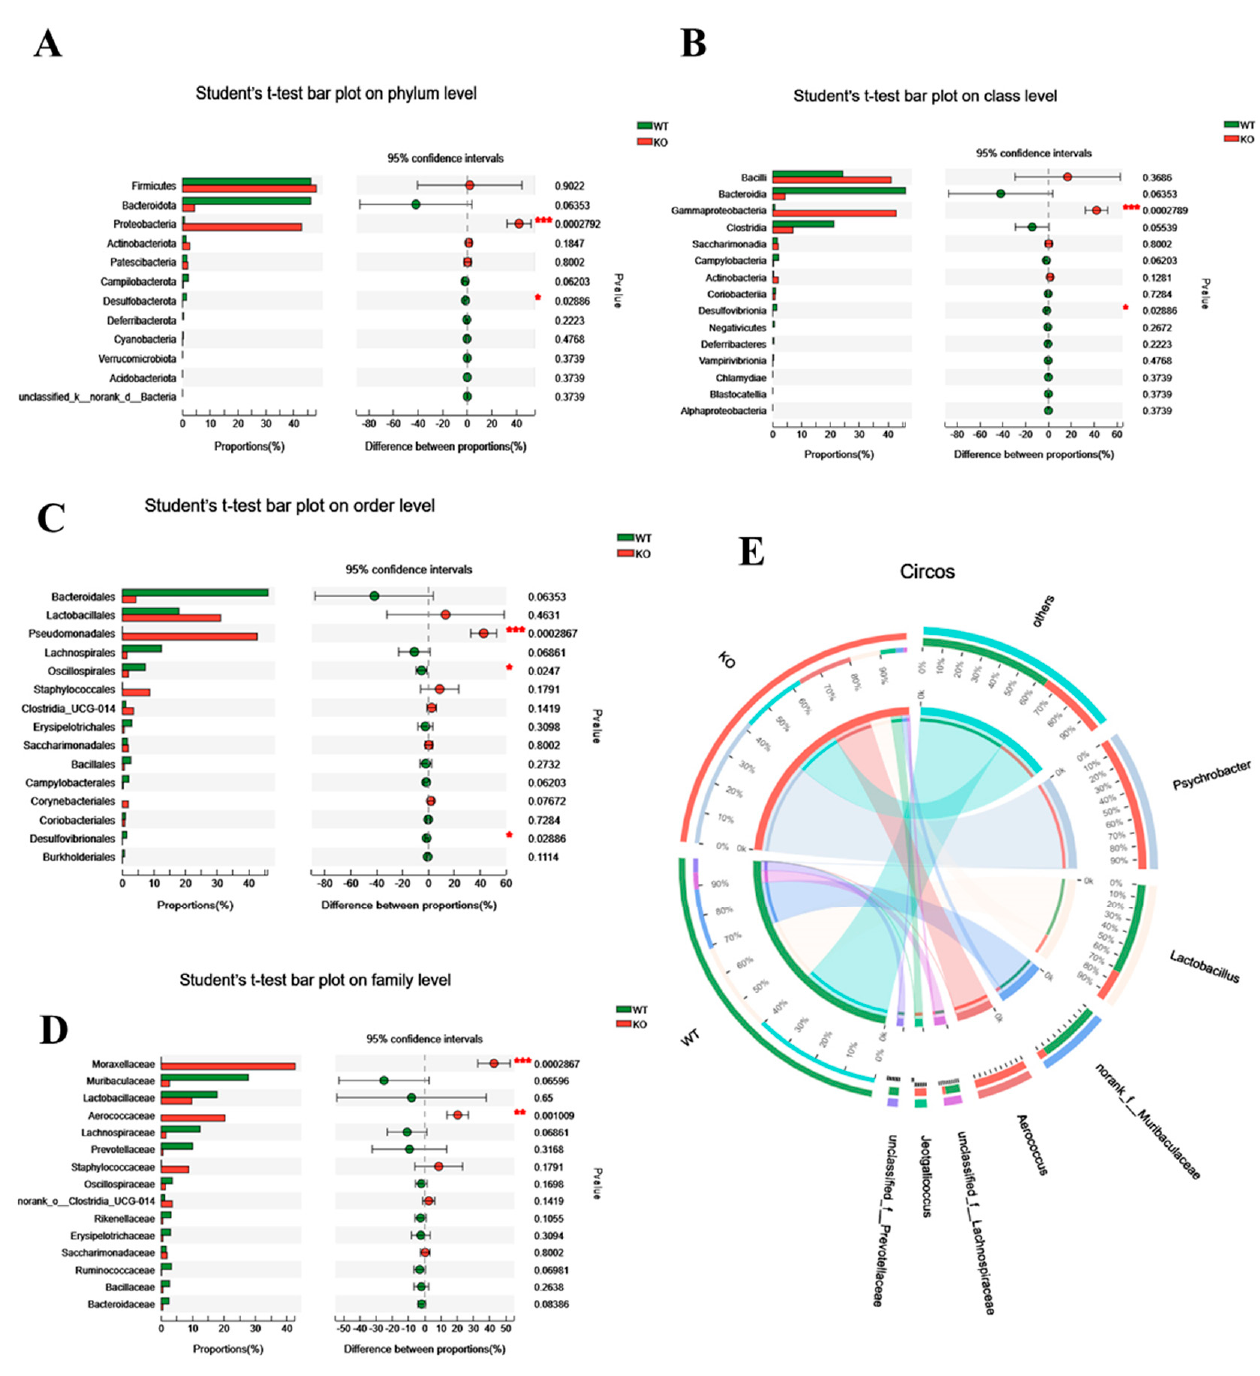
Figure 2. Differential abundance of gut microbiota between WT and KO mice. ( A – D ) Student’s t -test bar graph at the level of phylum ( A ), class ( B ), order ( C ), and family ( D ); the left side represents the gut microbiota category, and the right side represents the difference. ( E ) Circos genus relationship diagram. The left half-circle represents the genus composition in WT and KO mice, with the outer circle color representing WT (green) and KO (red). The right half-circle represents the proportion of distribution at the genus level. The color of the outer band represents different species, and the numbers on the inner circle represent the distribution proportion of a particular species in the WT (red) and KO (blue) groups. For each group of mice, n = 3. Data are expressed as the mean ± SEM. Student’s t -test, * p < 0.05, ** p < 0.01, *** p <